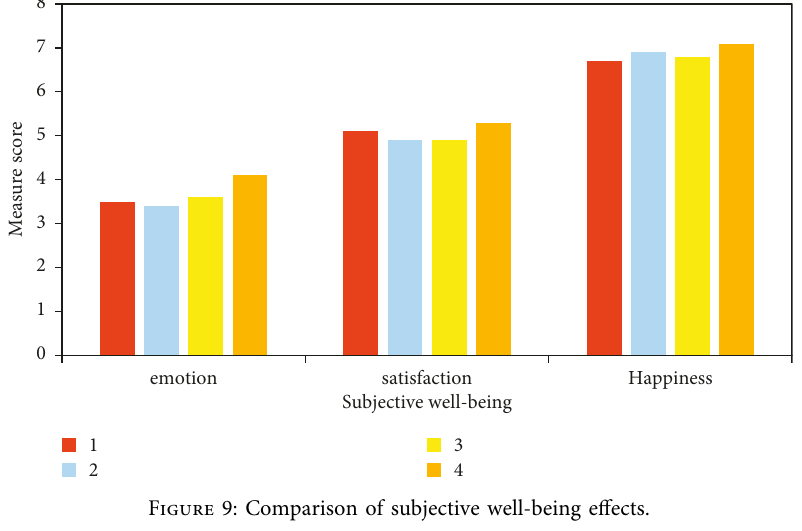
Figure 9: Comparison of subjective well-being effects.